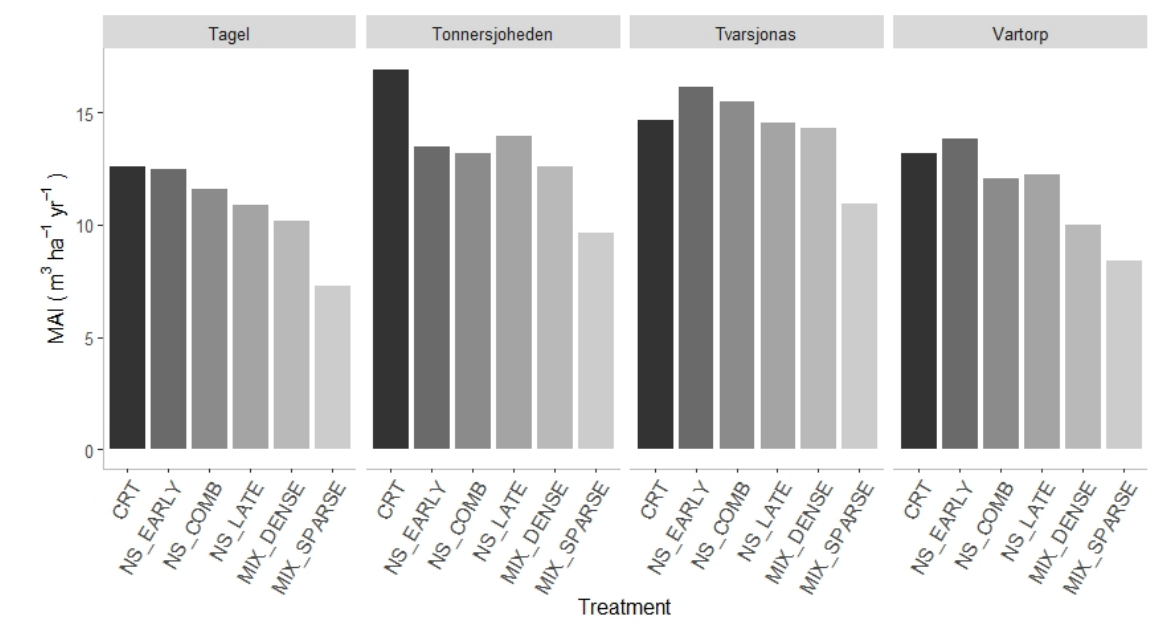
Figure 4. Mean annual increment (MAI) of stands during final felling across multiple sites and different PCT strategies. A 2% interest rate and “Birch pulpwood” assortment was used in the simulation. See Figure 3 legend for explanation of the treatments.